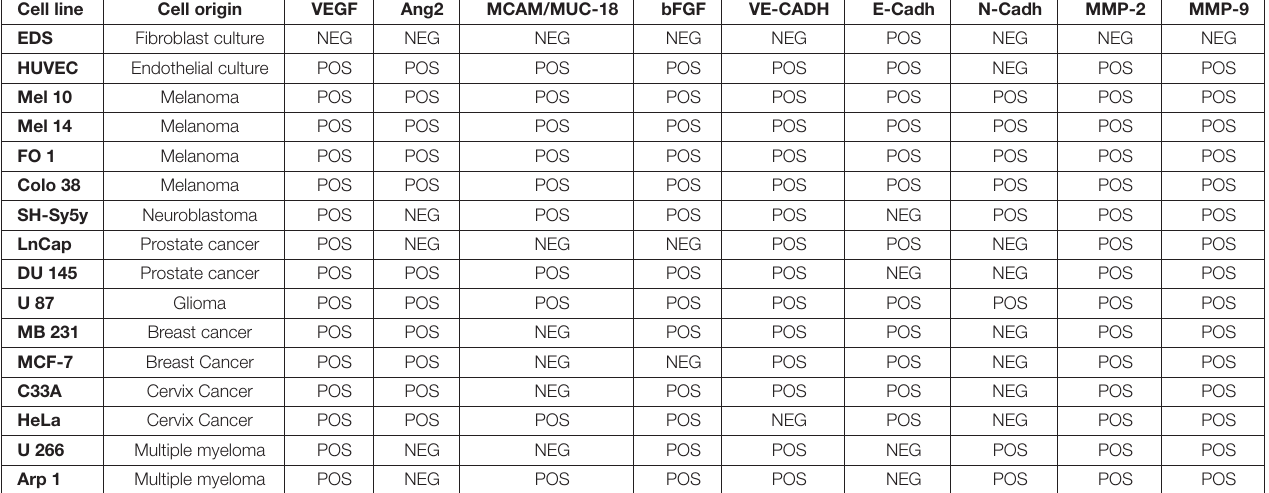
TABLE 2 | Analysis of expression of angiogenic factors, pro-angiogenic factors, cell-cell adhesion molecules, and Matrix-Metallo Proteinases in cell lines. Cell